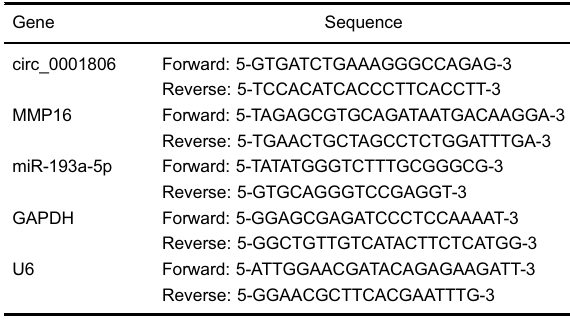
Table 1. Primer sequences used in this